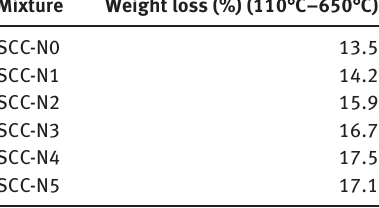
Table 6 Weight loss ( % ) of the pastes in the range of 110 ° C – 650 ° C for SCC